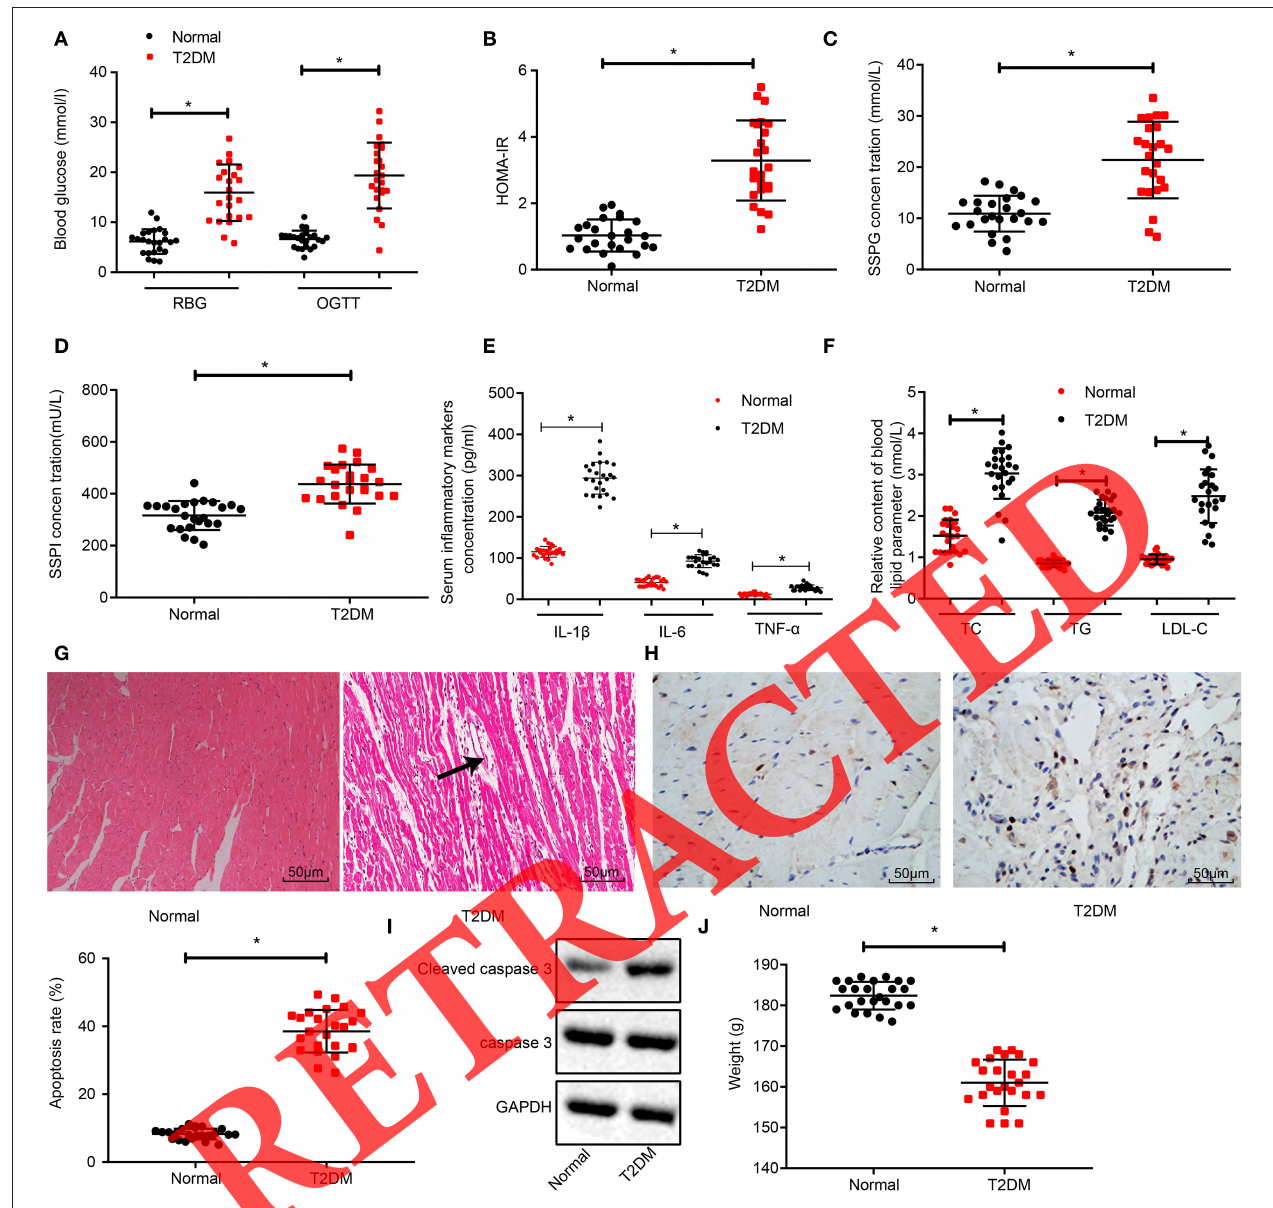
FIGURE 1 | Physiological indexes of rats in normal and T2DM groups. (A) RBG and OGTT between the normal and T2DM groups. OGTT was conducted 2h after the rats took 75g of glucose orally; (B) HOMA-IR between the normal and T2DM groups; (C) the level of SSPG between the normal and T2DM groups; (D) SSPI between the normal and T2DM groups. The data were analyzed by the unpaired t -test; (E) the levels of IL-1 β , IL-6, and TNF- α between the normal and T2DM groups; (F) the levels of TC, TG, and LDL-C between the normal and T2DM groups. The data were analyzed by an unpaired t -test; (G) the chromatogram of pathological sections of the normal and T2DM groups. The black arrow indicates the location of fibrosis ( × 200); (H) TUNEL staining of myocardial tissues of rats in the normal and T2DM groups; (I) Western blot used to detect the expression of cleaved caspase-3 in myocardial tissues of rats of the normal and model groups. (J) Body weight of rats in the normal and T2DM groups. * p < 0.05 vs. the normal group. The measurement data were presented by the mean ± standard deviation and analyzed using unpaired t -test. n = 24. RBG, random blood glucose; OGTT, oral glucose tolerance test; HOMA-IR, homeostatic model assessment for insulin resistance; T2DM, Type 2 diabetes